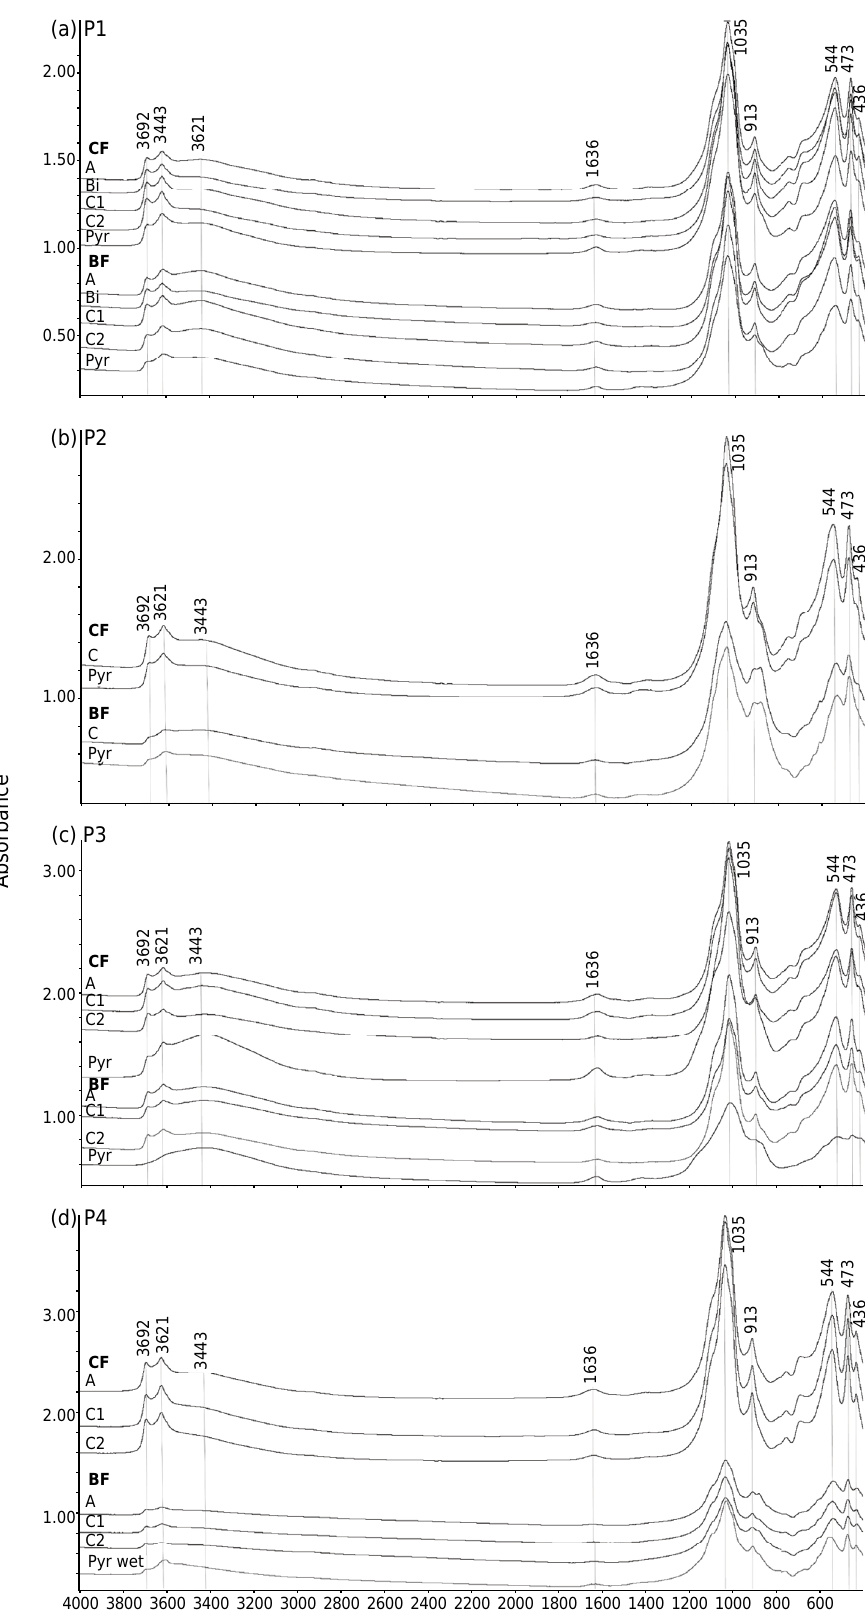
Figure 6. Medium infrared images of pedological horizons of P1 (a), P2 (b), P3 (c), and P4 (d) showing the spectrum of halloysite. In P3 is noted the presence of piques of material non-crystalline in the region between 400 cm -1 and 950 cm -1 . CF: clay fraction; BF: bulk fraction; Pyr: